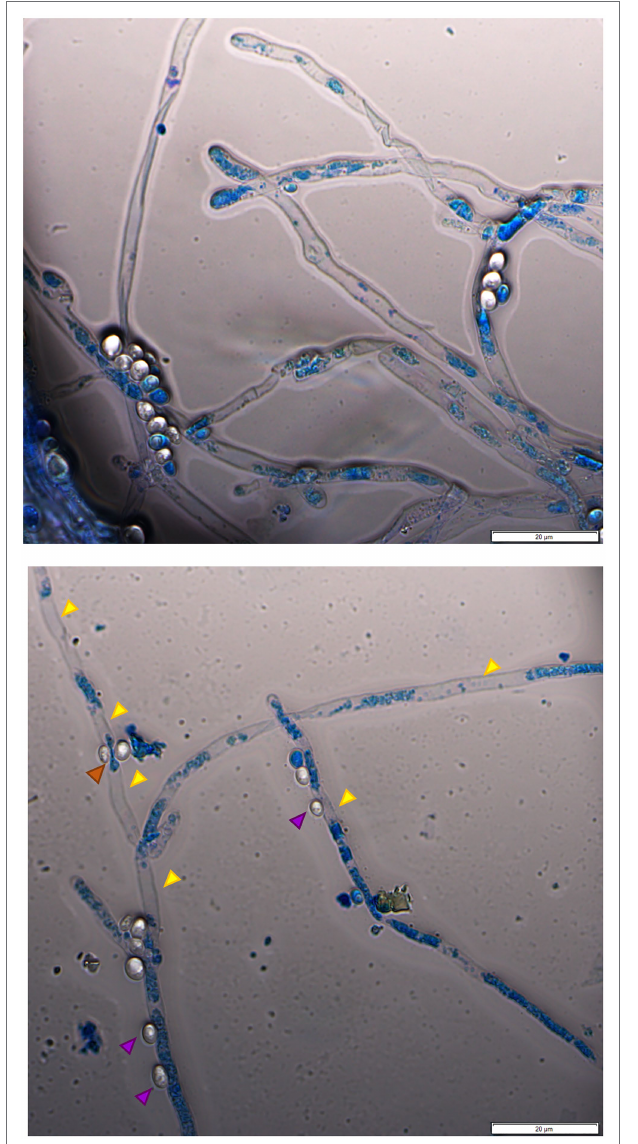
FIGURE 4 | Fluorescence microscopy image of W. anomalus #1105 and M. perniciosa CBS 442.80 co-culture stained with MB. The yeasts rather group while adhering to the hyphae (upper panel) . The hyphae are partially drained of their cellular content ( upper panel and lower panel , yellow arrows). Lower panel : yeast cells appear to push the hypha inwards (orange arrow); yeasts may cause a constriction of the hypha (purple arrow).